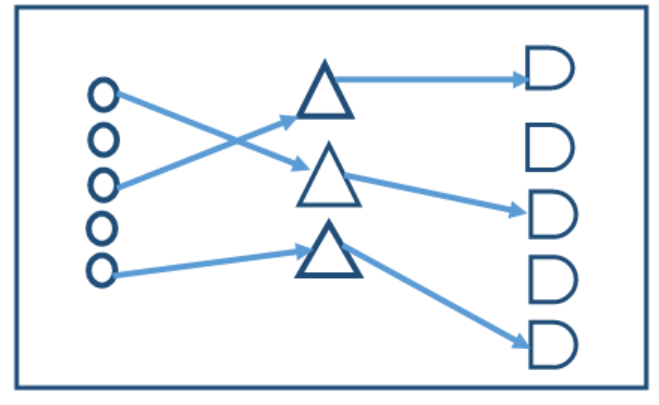
Figure 1. The unsolved special case of the generalized assignment problem (S-GAP).